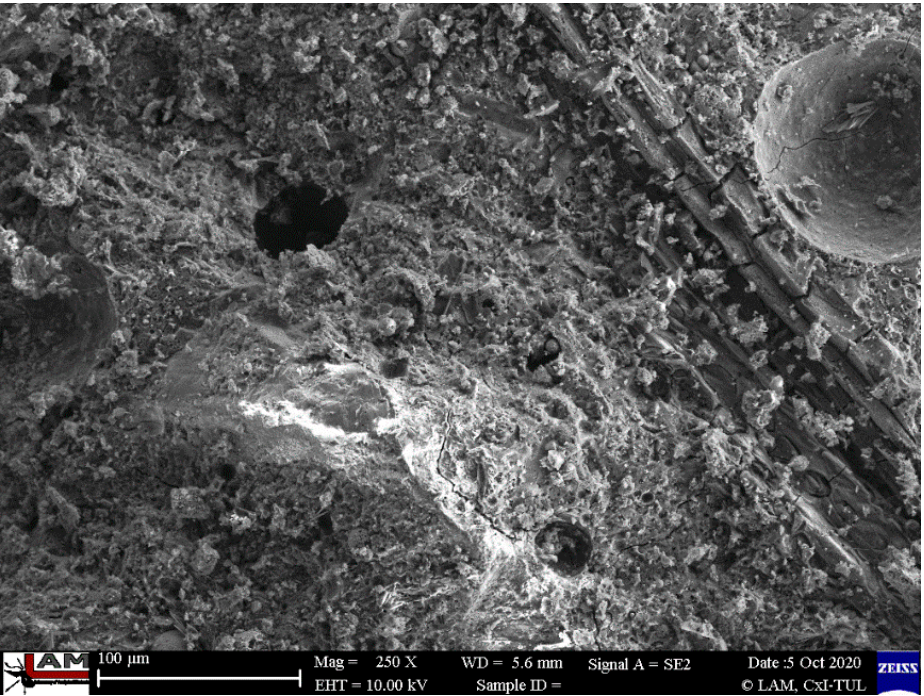
Figure 14. Microstructure of the cast samples reinforced with flax fibers with visible matrix structure and very good cohesion between sample and matrix.